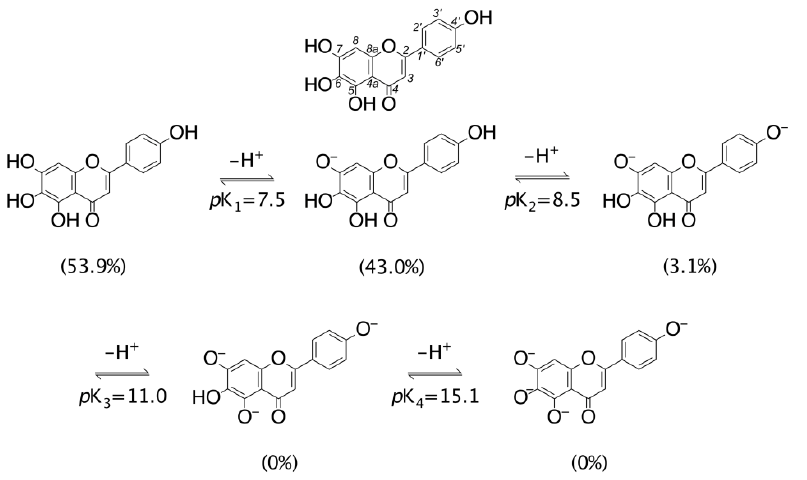
Figure 1. Structure of scutellarein (H 4 A) and pKa values of the relative deprotonation paths and molar fractions of the different scutellarein acid-base species (in parentheses), at physiological pH.